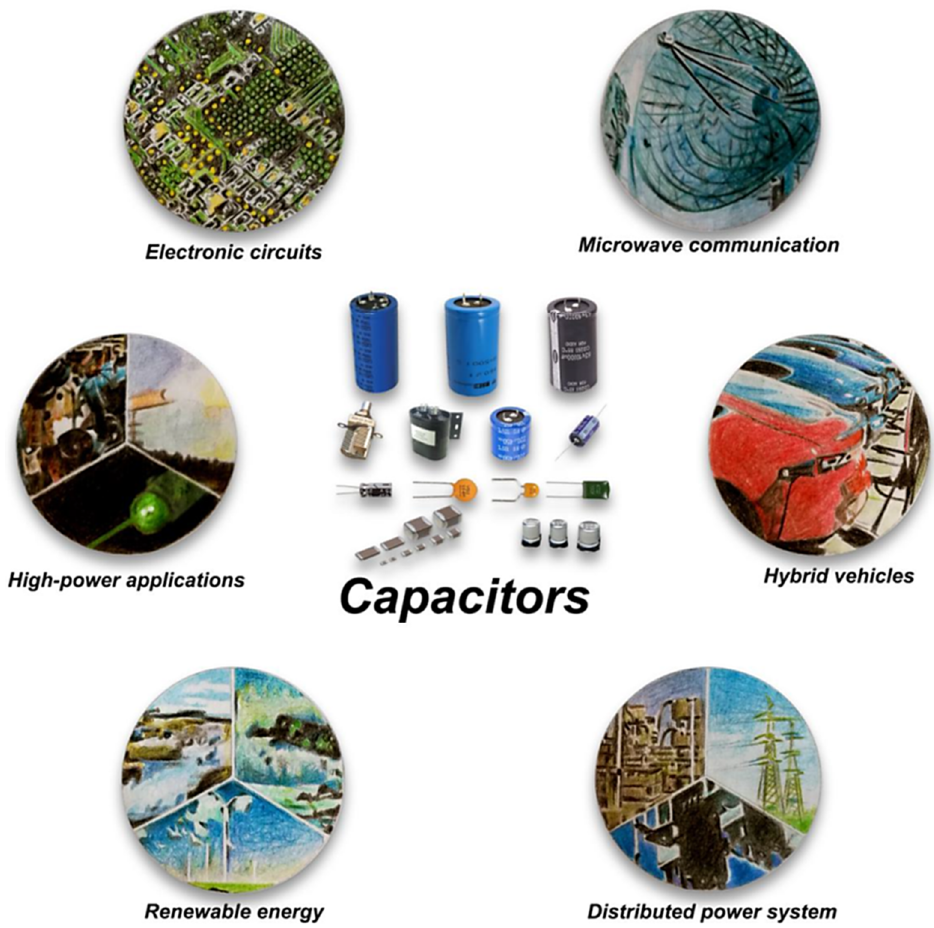
Figure 9. Application fields of capacitors [119]. Reproduced with permission from Elsevier.